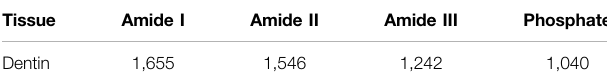
TABLE 1 | Wave numbers of dentin by Fourier-transform infrared spectroscopy.